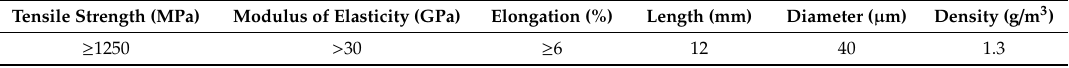
Table 2. Properties of polyvinyl alcohol (PVA)